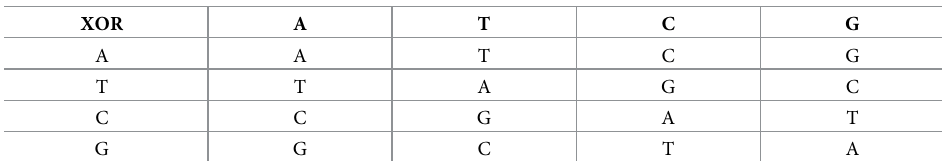
Table 2. DNA XOR